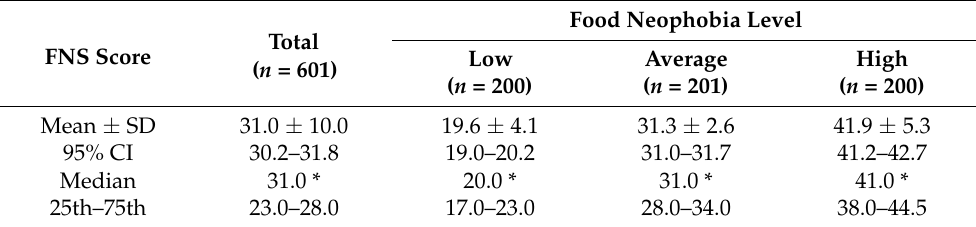
Table 3. The FNS scores in the participants of the study ( n =